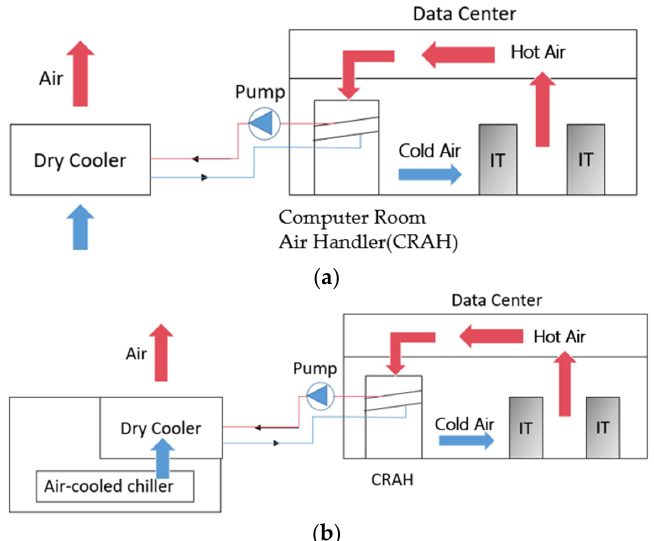
Figure 6. Two types of air-cooled systems working as water-side economizers: ( a ) independent dry cooler; ( b ) integrated dry cooler with air-cooled chiller.